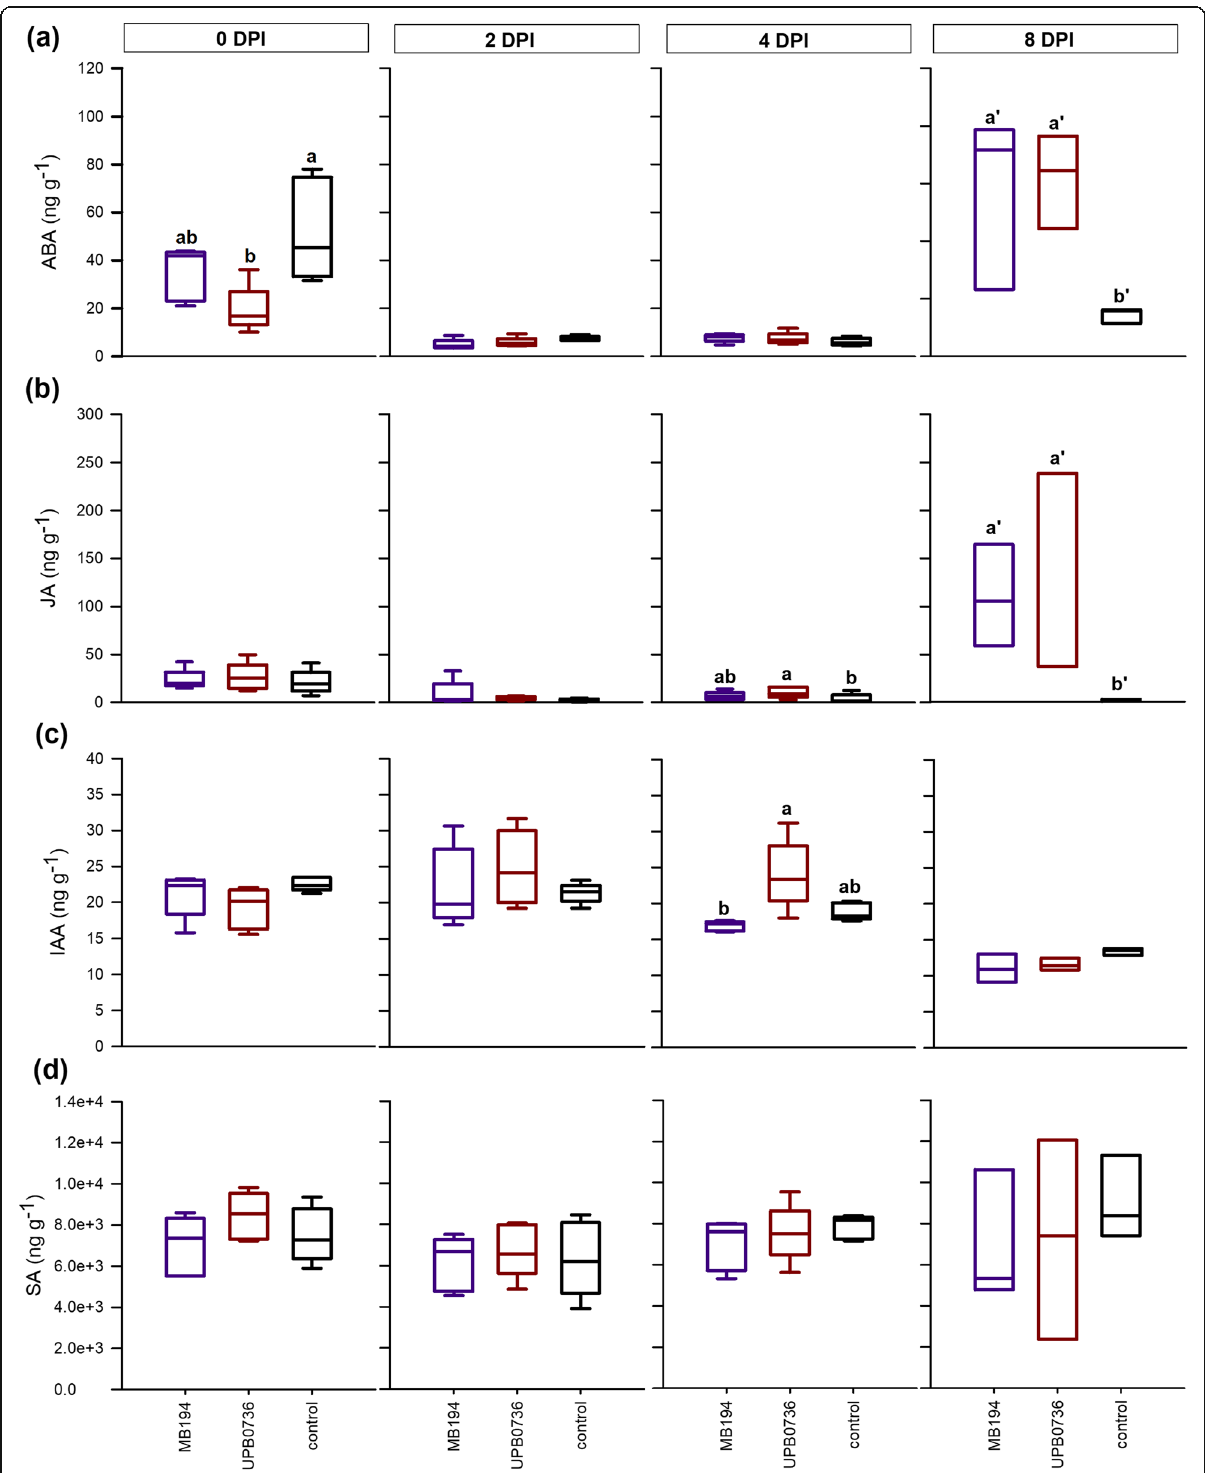
Fig. 5 (See legend on next